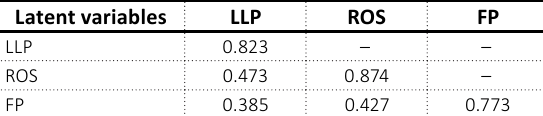
Table 2. Average Variance Extracted (AVE) for